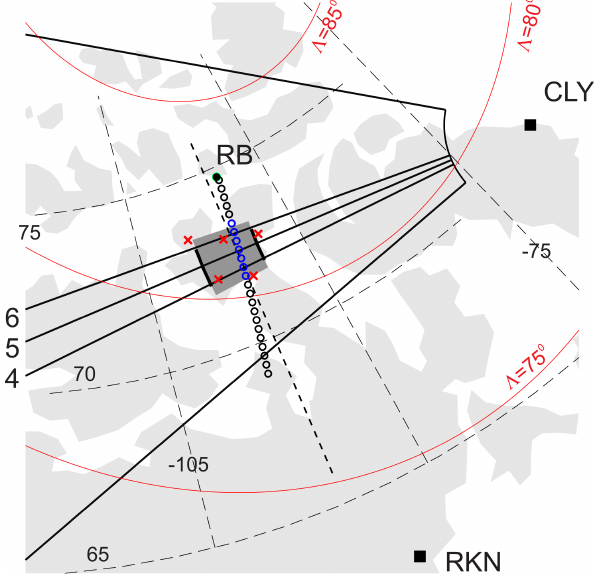
Figure 1. Field of view of the SuperDARN radar at CLY. The black straight lines are the orientation of specific beams (4–6) that were considered in this study. Shaded areas represent areas of HF radar data averaging. RB is the location of the RISR-C ISR. The radar reports the E × B vector with a bin size of 0.25 ◦ of geographic lat- itude for points shown as black circles stretching roughly along the magnetic meridian crossing the RB zenith. The blue-colored circles are those locations whose data were used for comparison with the CLY measurements. The solid red arcs are the magnetic latitudes of 75, 80, and 85 ◦ .